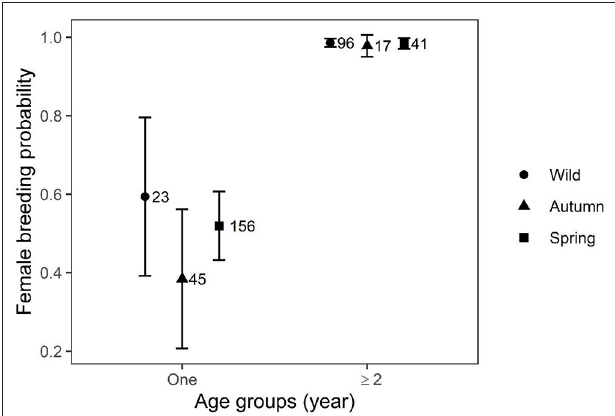
FIGURE 2 | Predictions of female mean breeding probabilities ( ± CI) of wild-born and captive-bred migrant Asian houbara ( Chlamydotis macqueenii ) released in spring and autumn.